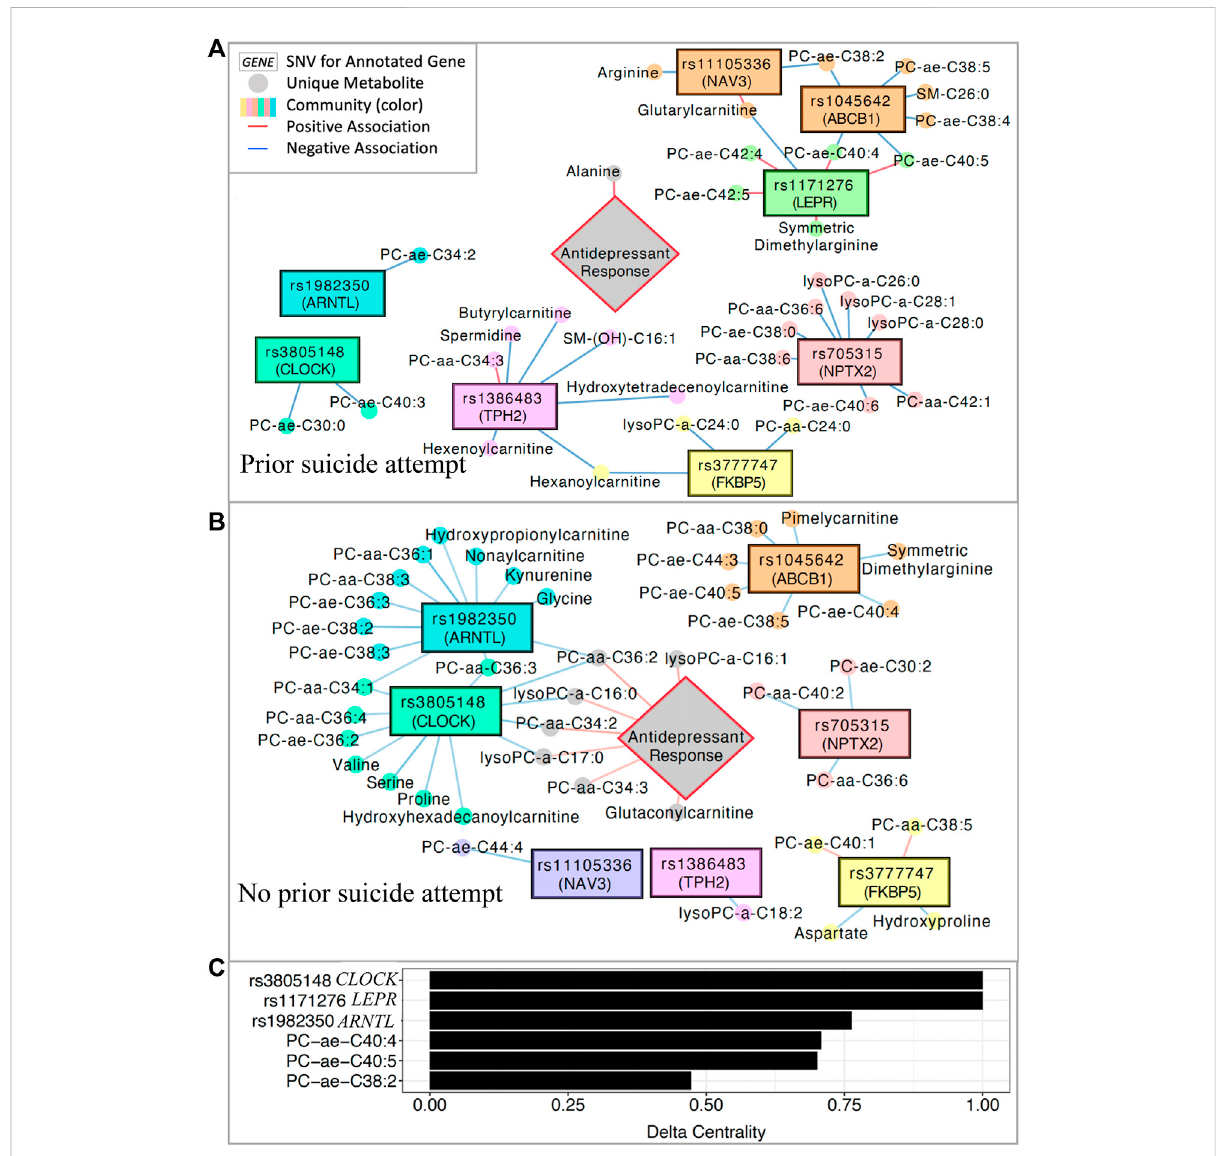
FIGURE 3 Multi-omics integration network. (A) Signi fi cantly associated SNVs and metabolites in patients with a history of suicide attempt and (B) patients withnohistoryofsuicideattempt. (C) Deltacentralityscoresforthe fi vevariableswiththehighestdeltacentralityvalues.Deltacentralityisde fi nedas the change in eigenvector centrality across networks (lifetime history of suicide attempt vs. no history). Delta centrality ranges from 0 – 1, with 1 indicating the greatest differences in number and quality of connections across networks. PC: phosphatidylcholine; SM: